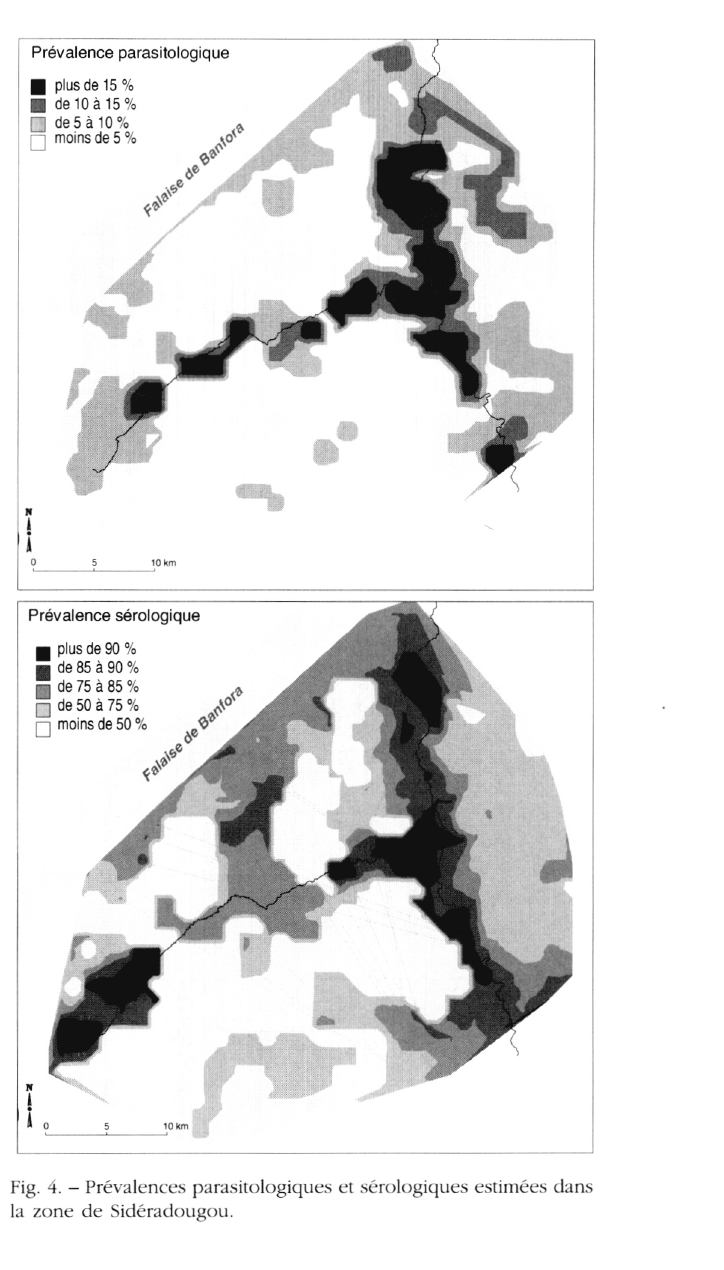
détenu par des éleveurs Peuhl, localisés dans la partie pastorale au sud-ouest de la zone (village de Nakaka) (fig. 1). Le second est constitué d’animaux